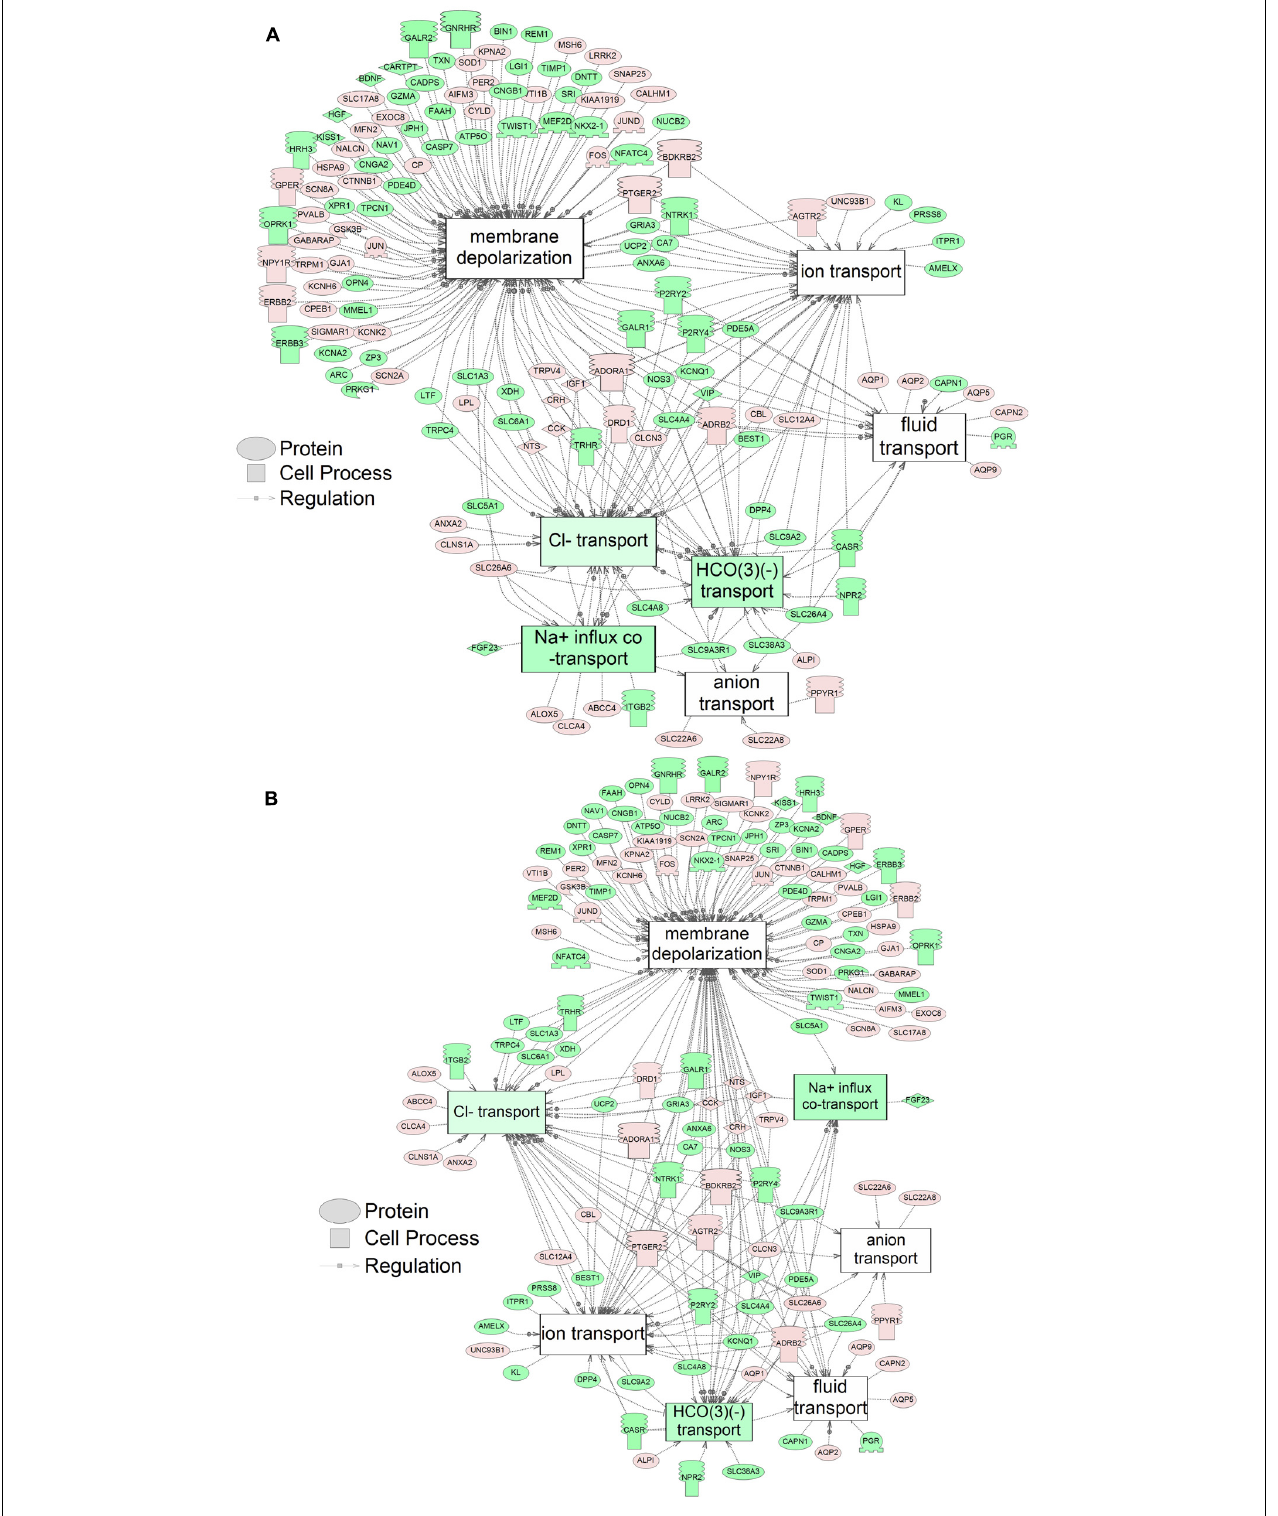
FIGURE 3 | Networks associated with membrane integrity indicating altered gene regulation following exposure of S. tropicalis to 2 mg/L of S1 (A) and S2 (B) . Sub-network enrichment analysis (SNEA) was performed using Pathway Studio 9.0. Pink and red indicate that the transcript abundance was increased and green indicates that the transcript abundance was decreased ( p < 0.05). The abbreviations are the official gene symbol of the transcripts of the respective pathway ( Supplementary Tables S8, S9 ).